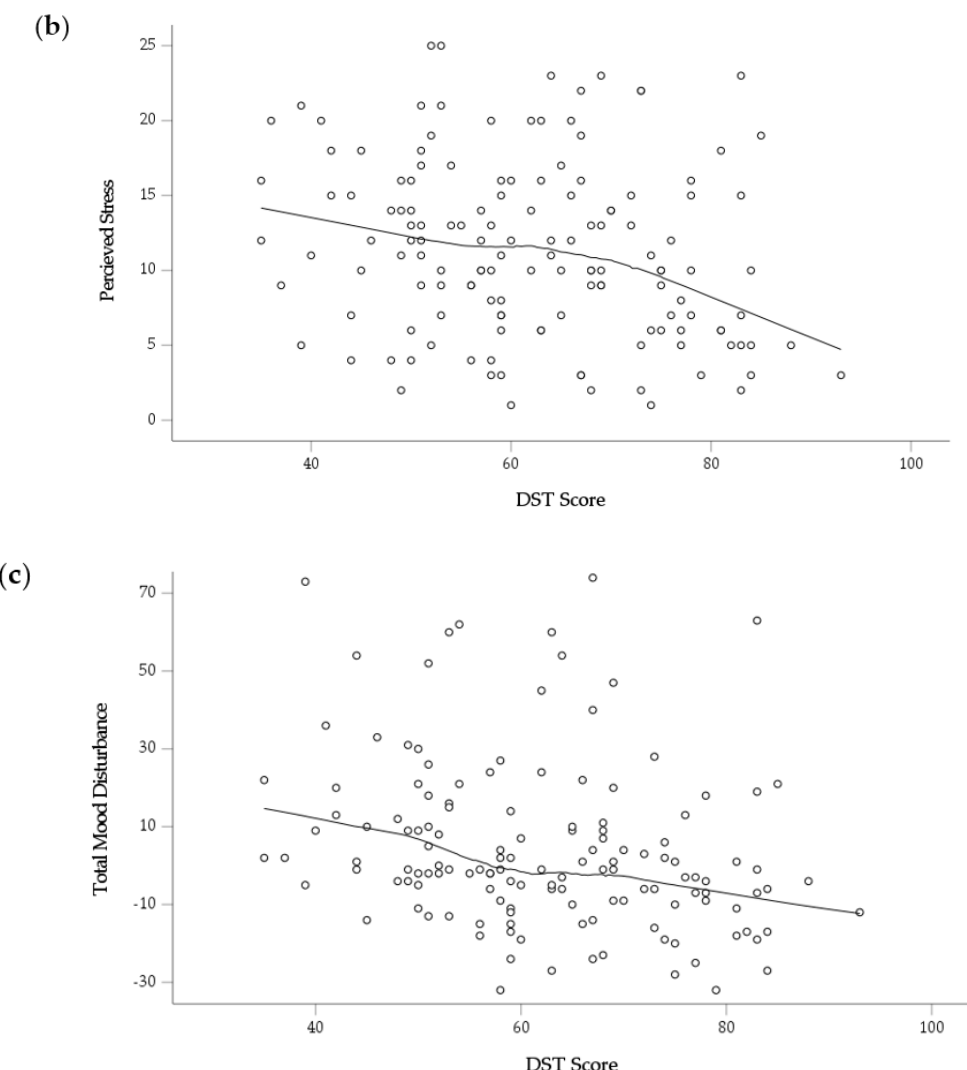
Figure 3. Locally weighted smoothing scatterplots demonstrating how diet quality (DST score) is related to ( a ) Stroop Processing (Z score, di ff erence between Incongruent and Congruent performance); ( b ) Perceived Stress; ( c ) Total Mood Disturbance.